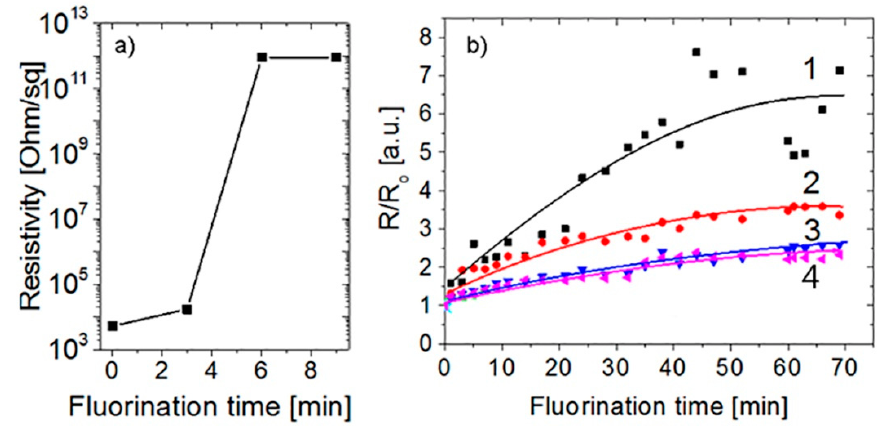
Figure 3. Changes in the resistivity under the fluorination process for the CVD-grown MG transferred onto ( a ) the SiO 2 /Si and ( b ) PET substrates. In the case of ( b ), different curves correspond to the different tested structures.